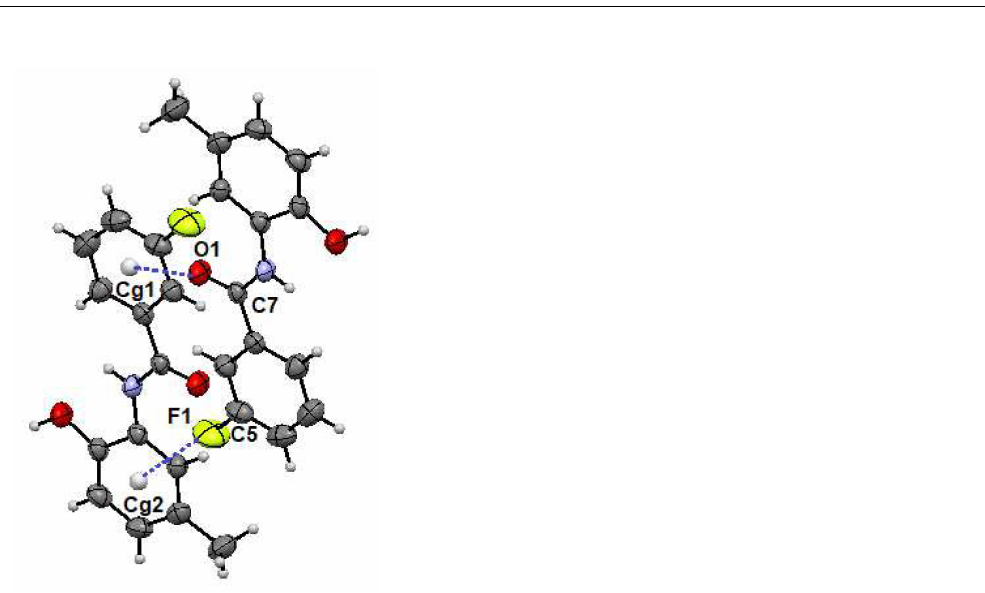
Figure 4. C-O ··· Cg and C-F ··· Cg interactions in m -FPhB are highlighted in dashed blue